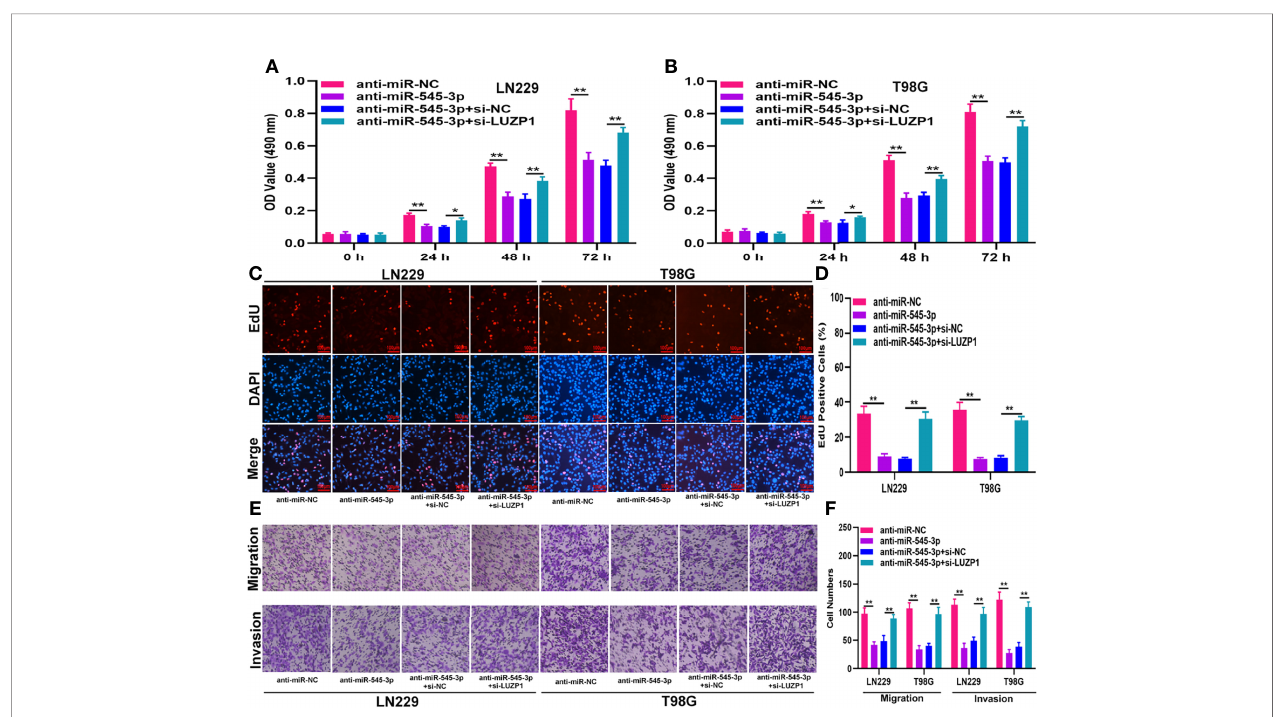
FIGURE 6 | LUZP1 downregulation restored the effect of miR-545-3p knockdown on glioma cells. (A, B) The proliferation of indicated cells was tested by MTT. (C, D) The proliferation of indicated cells was tested by EdU. (E, F) Transwell assay was conducted to measure the migration and invasion capacity of T98G and LN229 cells after transfection. *P < 0.05, **P <